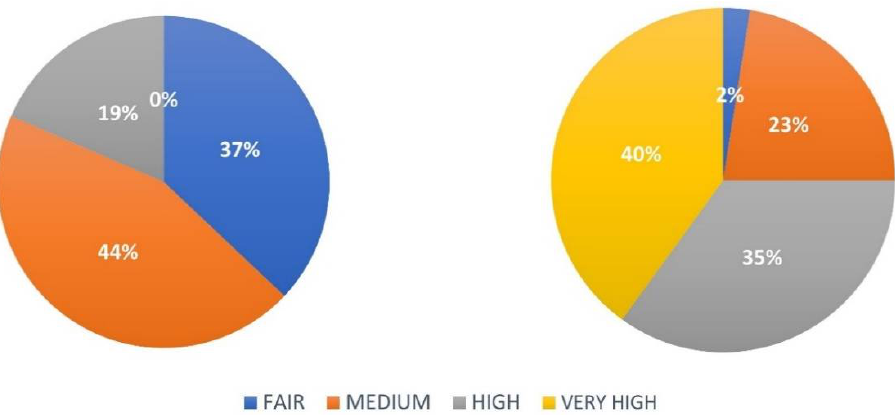
Figure A7. Distribution of vulnerability levels referring to the freeboard for opening obstructions in the main ( left ) and the secondary ( right ) hydrograph networks.